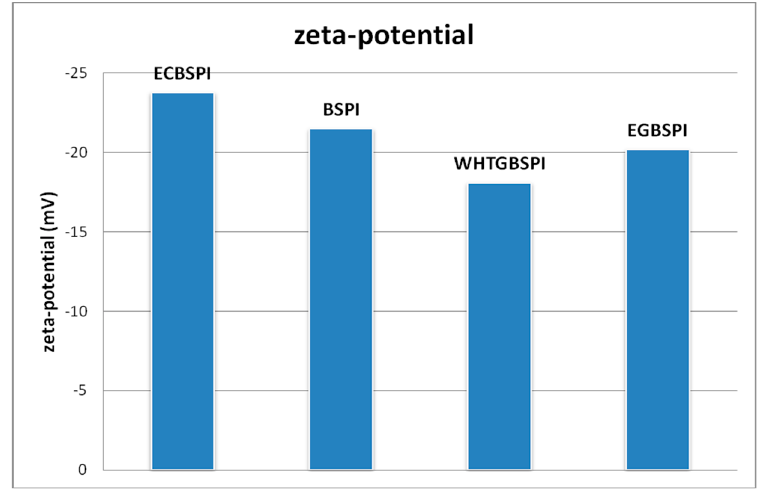
Figure 6. Zeta-potential of BSPI and its modified products.